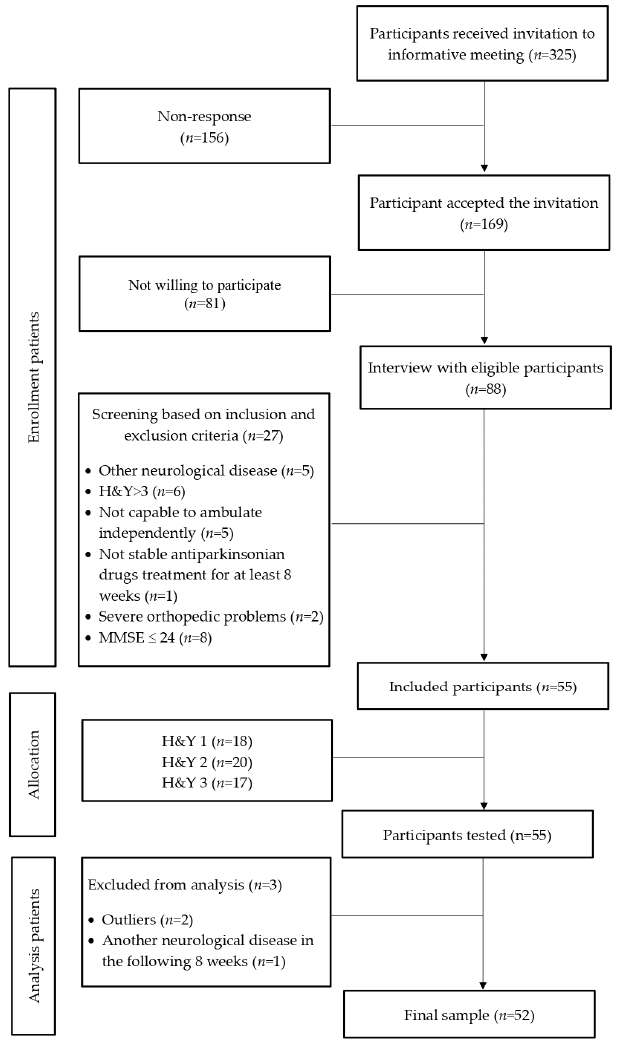
Figure 1. Flow diagram of the participants’ inclusion process.